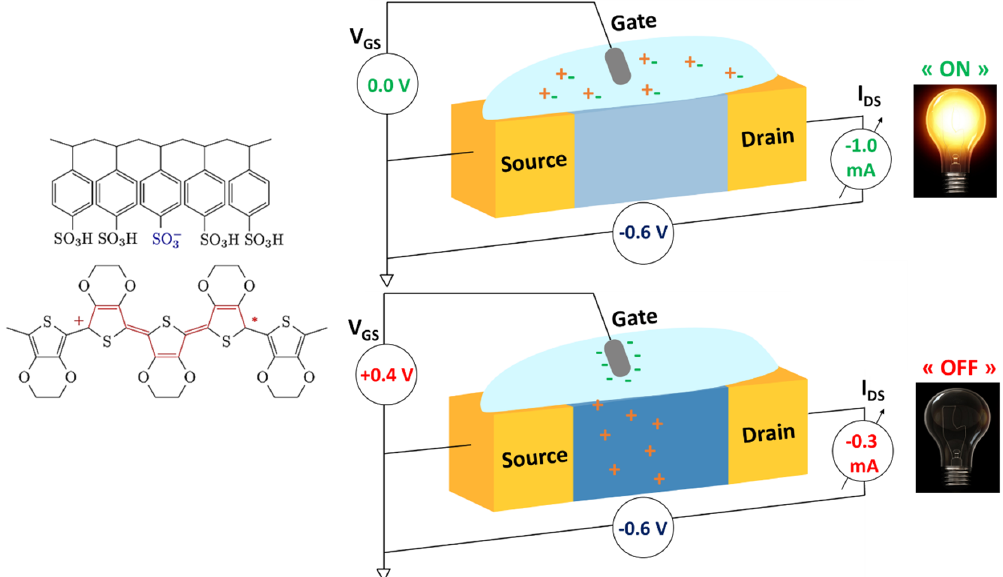
Figure 1. Schematic of an organic electrochemical transistor (OECT). A bias voltage ( V DS ) is applied between two electrodes, source and drain, which are connected by a channel made of an organic semiconductor, e.g., p-type poly(3,4-ethylenedioxythiophene) doped with polystyrene sulfonate (PEDOT:PSS). This channel is in contact with an electrolyte where a third electrode is immersed, the gate electrode, V G , (i.e., Ag/AgCl electrode). ( Top ): In the absence of a gate voltage, the channel is in its conductive (oxidized) state; this is the “on” state of the device. ( Bottom ): Application of a positive voltage results in reduction of the channel material (neutral state), switching the device to the “off” state.